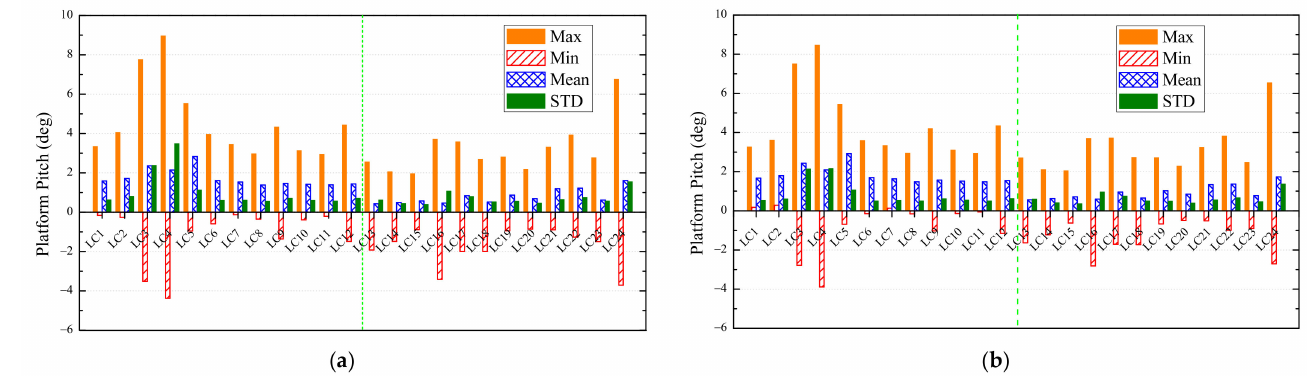
Figure 14. Statistics of platform roll motion response for ( a ) without current; ( b ) with current.